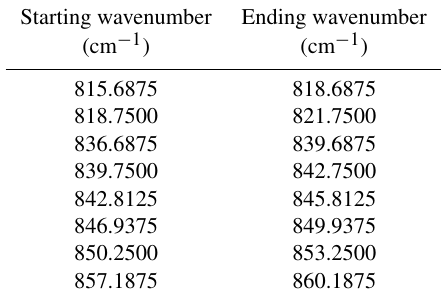
Table 1. MWs selected for MTR retrievals of COCl 2 and CFC-11.